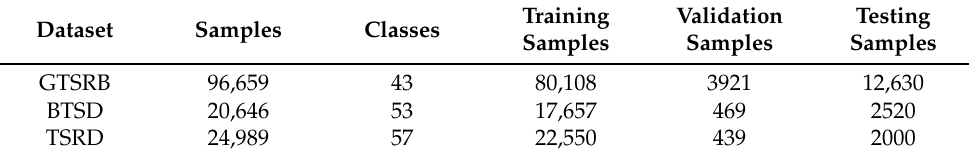
Table 4. Summary of datasets.